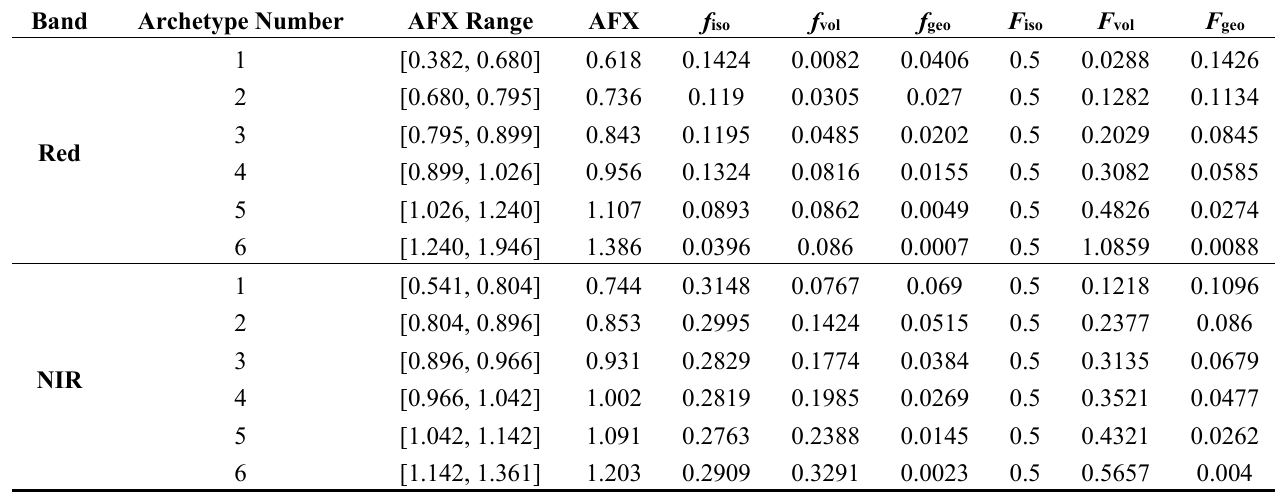
, F , F ) forms in the MODIS red and NIR iso vol geo